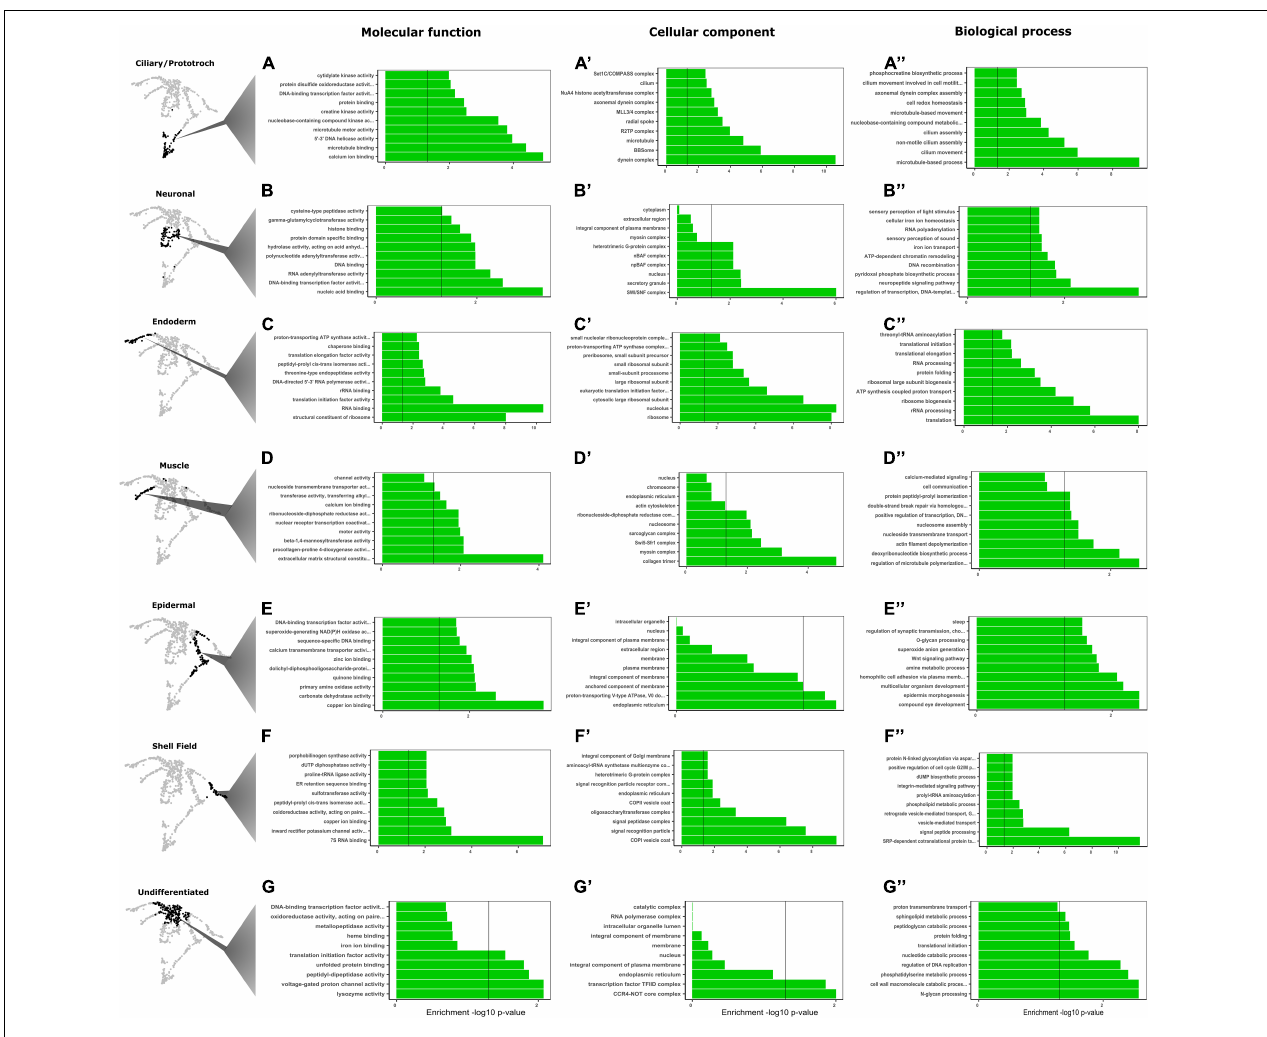
FIGURE 2 | Gene ontology (GO) analyses leads to identification and validation of clusters of differentially expressed genes. (A–G”) GO terms associated with molecular function, cellular component, and biological processes. Classification of the corresponding GO terms form each highlighted cluster on the left side of the panel. Each row represents a cluster with significant transcriptomic signature and each column shows the categories of enrichment by molecular function, cellular component, and biological processes. Vertical black line ( p -value = 0.05) in each graph represents statistical significance threshold set after performing a Fisher’s exact